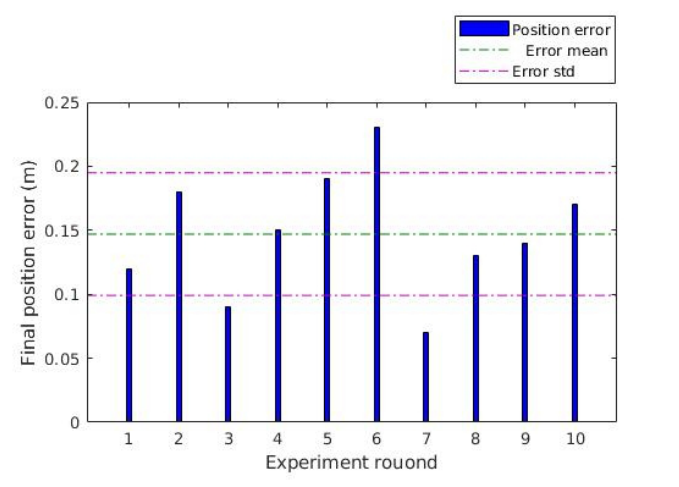
Figure 13. Position error of the unmanned ground vehicle (UGV) displacements: Position error of indoor experiment.